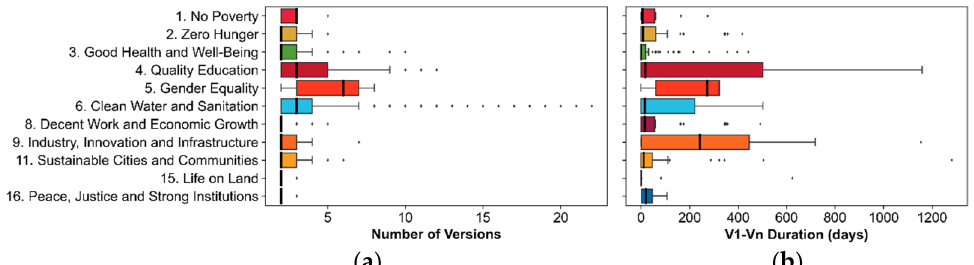
Figure 11. ( a ) The frequency of terminal version numbers (Vn), and ( b ) the total duration between V1 (creation) and Vn (terminal version) dates for SDG data in refugee settlements. Interquartile range (IQR) (25–75%) shown in colored boxes, median value shown as thick black line, whiskers extend to an IQR value 150% below Q1 or over Q3 to show the minimum and maximum respectively, and outlier values are shown as single dots.